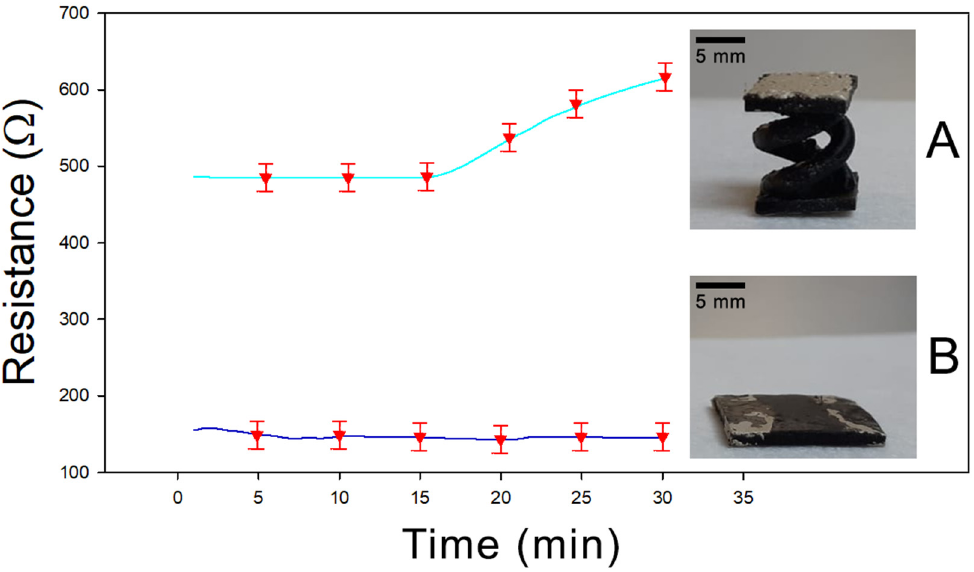
Figure 7. ( A ) Resistivity of 3D-printed double helical sample under acetone exposure. ( B ) Resistivity of 3D-printed parallelepiped shape under acetone exposure.